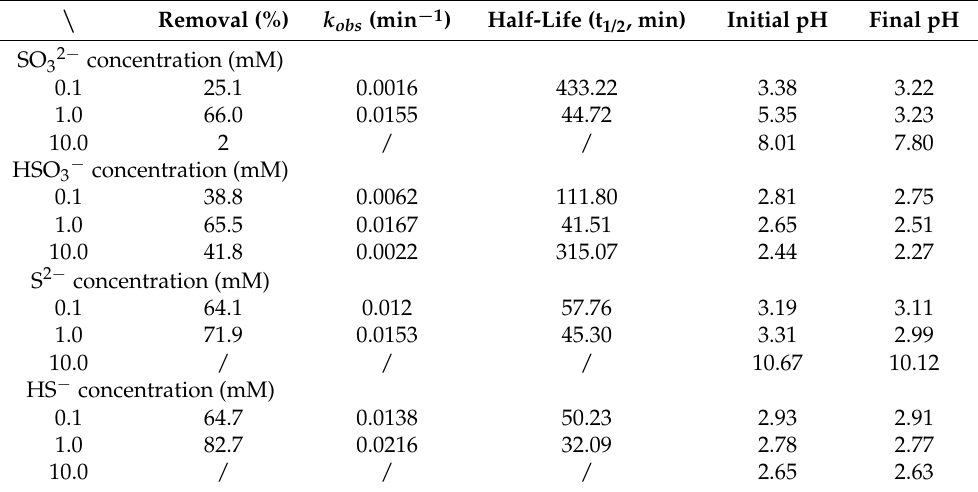
Table 1. The kinetics for BPA removal in 40 min under different S species ions